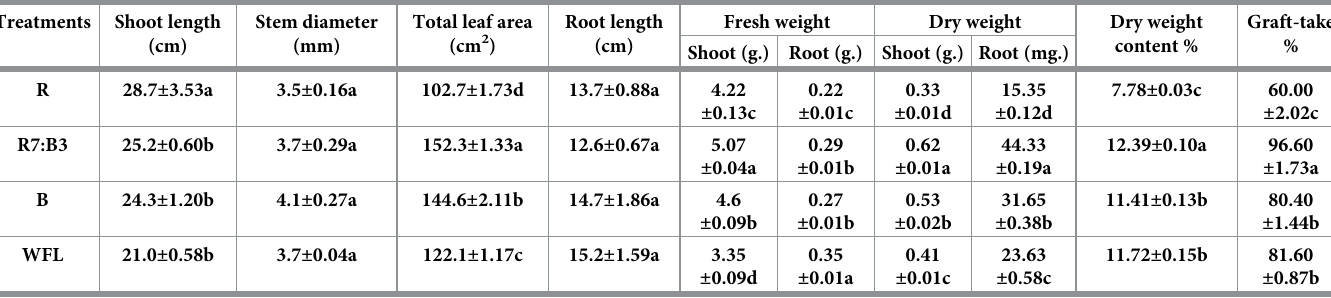
Table 3. Effect of LED light ratios on growth characteristics of grafted seedlings. Treatments Shoot length (cm)